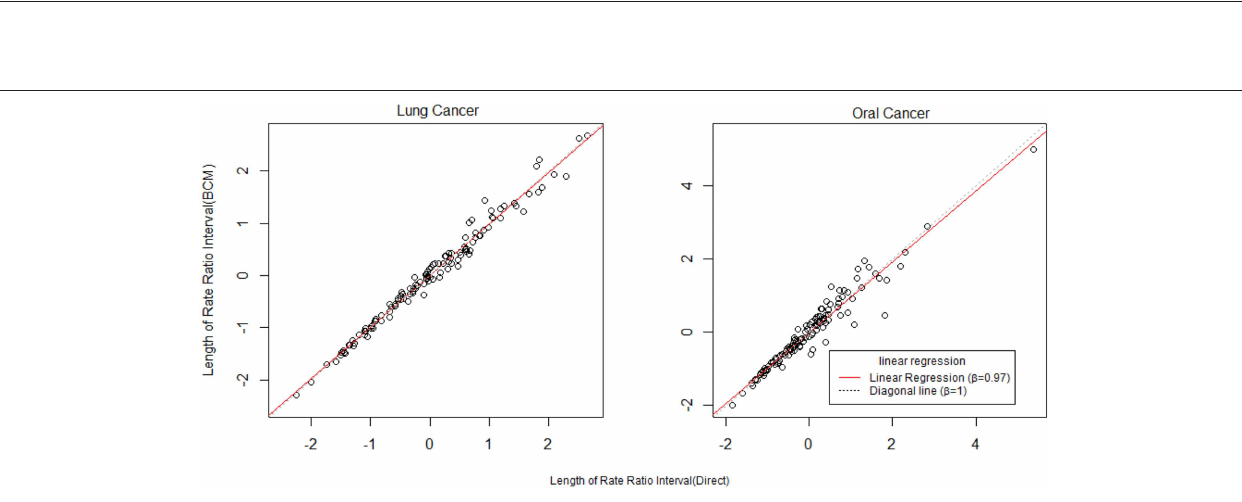
FIGURE 6 | The comparison of rate ratio interval length between Direct method and BCM model (After standardization). β is the slope for